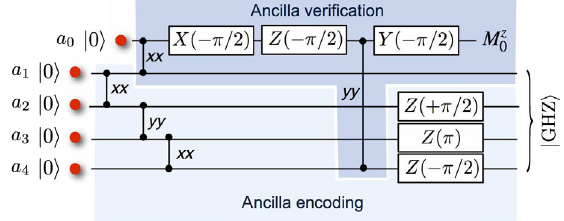
8. MS-based circuit for preparation and verification of a GHZ state in the DiVincenzo-Shor scheme: The first three MS gates create a four-qubit GHZ state, which is, up to single- qubit Z rotations, equivalent to the desired GHZ state ffiffiffi p 2 ; x ; x ; x ð 1 = Þðj x i þ j x − ; x − ; x − ; x − iÞ . The state is verified þ þ þ þ by coupling it via two additional MS gates involving the first and the fourth ancilla qubit to a verification qubit. Note that the Z -type rotation on the ancilla verification qubit is incorporated to remove a relative phase in the GHZ state. Some parts of the circuit can be executed in parallel, such as part of the verification circuit, while the GHZ state is still being built